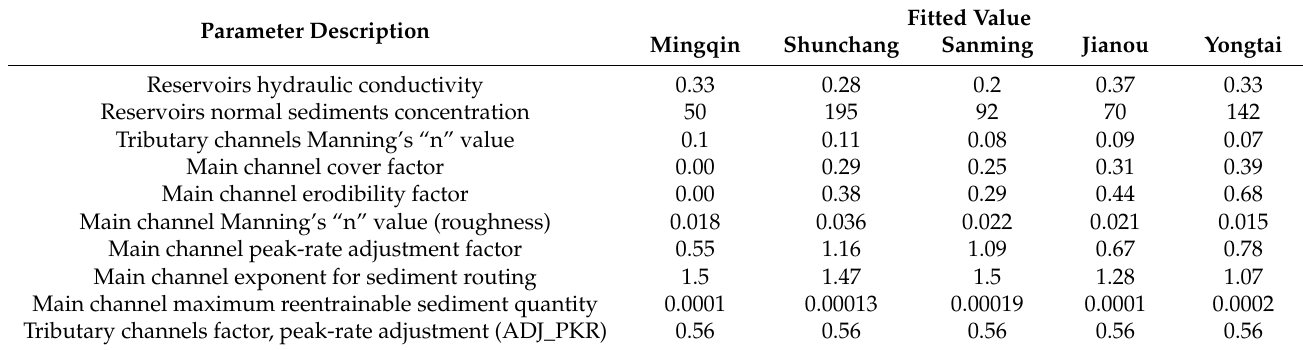
Table 1. Calibrated parameter descriptions and fitted